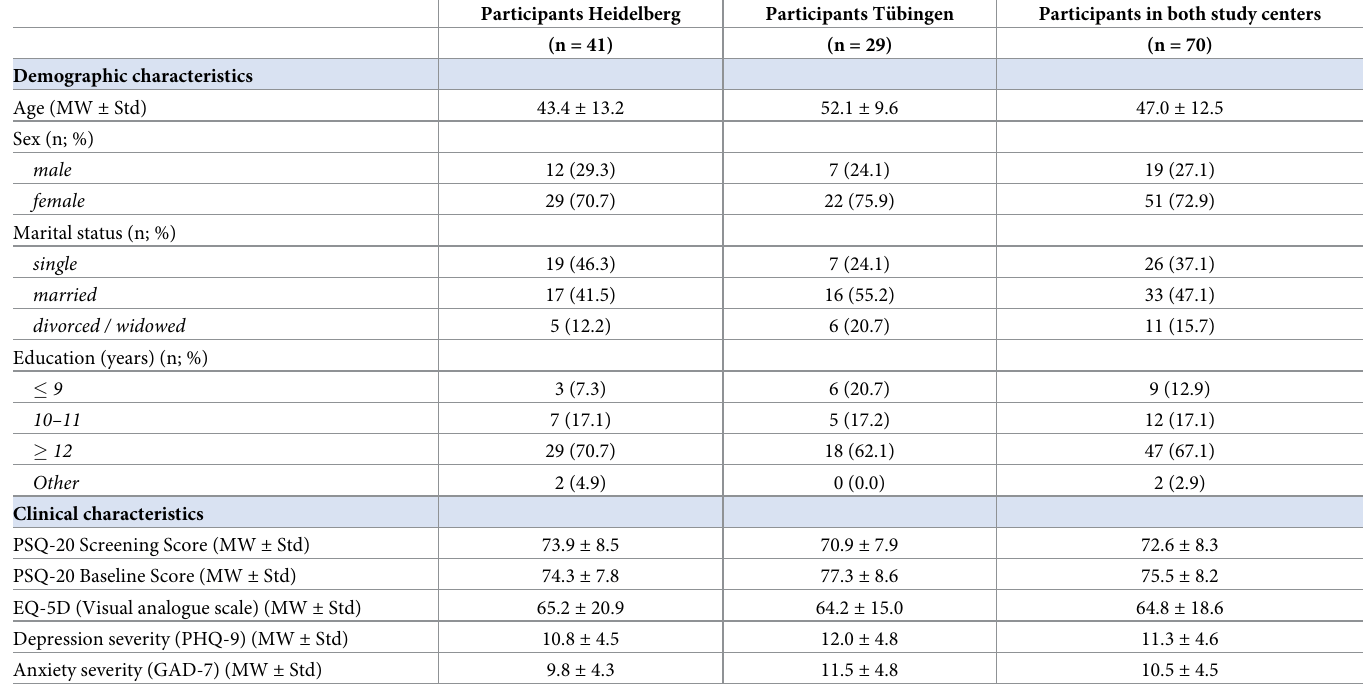
Table 1. Baseline characteristics of the study